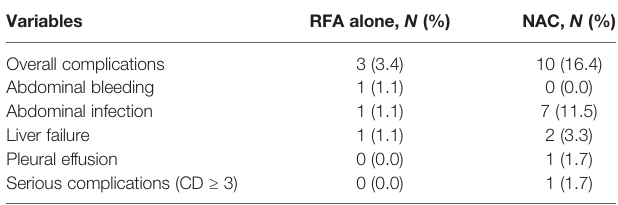
TABLE 3 | Post-RFA